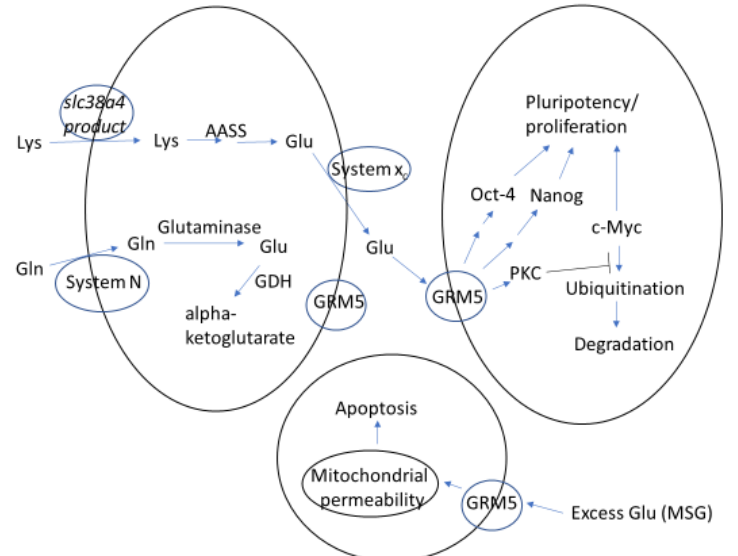
Figure 1. Proposed mechanism for carful regulation of glutamate (Glu) production and signaling in the ICM of blastocysts and how excess Glu may lead to reduced cell number in the ICM, in part, via apoptosis. For simplicity, only three cells are depicted, and processes that likely occur in all cells are shown in only one cell at a time. Plasma and mitochondrial membranes are illustrated by black ovals and amino acid transport systems and glutamate receptors by blue ovals in the plasma